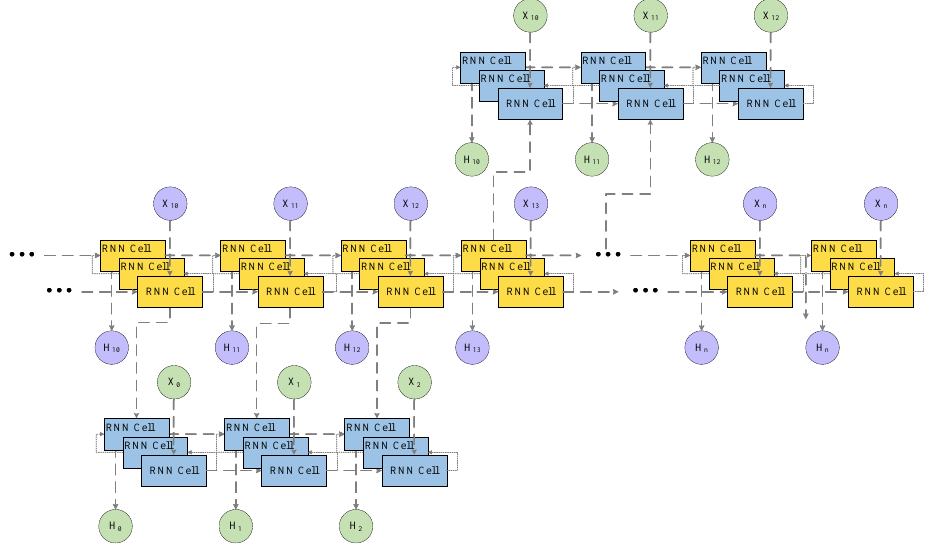
Figure 3. The decoder module with unsupervised auxiliary summarization loss. Yellow RNN cells represent decoder networks, blue RNN cells represent auxiliary loss modules. X represents the input features. H represents the decision of RNN cells based on